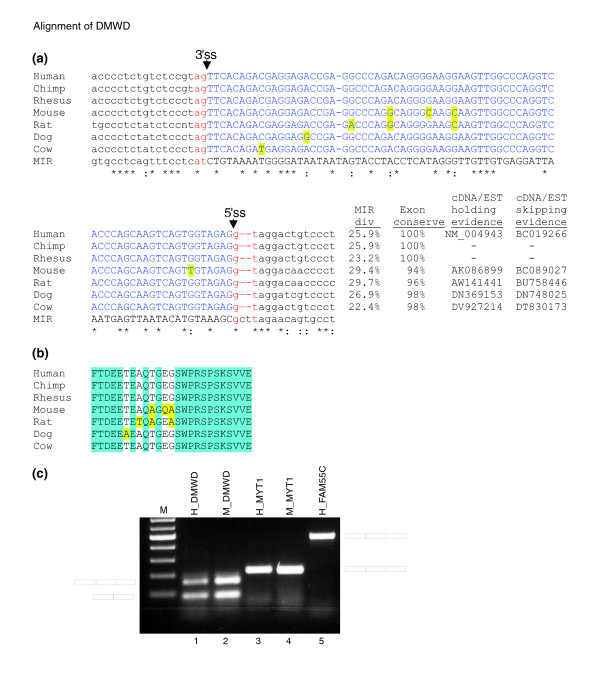
RT-PCR analysis of selected Alu and MIR exons. (a) Multiple alignment of mammalian interspersed repeat (MIR) exon in DMWD gene among mammals. Exon sequences are marked in blue, flanking intronic sequences are marked in black, and the canonical AG and GT dinucleotides at the 3'ss and 5'ss are marked in red. Nucleotide conservation is marked at the lower edge, with asterisks indicate full conservation and colons indicating partial conservation relative to the MIR consensus sequence (lower row). The divergence in percentage from the consensus MIR sequence is indicated under (MIR div); exon conservation in percentage compared with the human exon is indicated under (exon conserve); EST/cDNA accession confirming the exon insertion is indicated under (cDNA/EST holding evidence), and skipping is indicated under (cDNA/EST skipping evidence). Nonconserved nucleotides are marked in yellow. (b) This panel is similar to panel a, except that the conservation is shown for the protein coding sequence. (c) Total RNA was collected from SH-SY5Y human cell line and mouse brain tissue. Reverse transcription polymerase chain reaction (RT-PCR) analysis amplified the endogenous mRNA molecules using primers specific to the flanking exons. The PCR products were separated on an agarose gel, extracted and sequenced. A schema of the mRNA products is shown on the left and right. Columns 1 to 4 show the splicing pattern of orthologous human (H) and mouse (M) exons originating from the MIR element. Columns 1 and 2 show alternative splicing of an ortholog MIR element in both human and mouse, respectively (exon 4 in DMWD gene), and columns 3 and 4 show a constitutive pattern in both species (exon 5 in the MYT1L gene). Column 5 shows constitutive splicing of an Alu element in the human exon 3 of FAM55C gene. All PCR products were confirmed by sequencing. We cannot fully reject the option that an exon that is constitutively spliced under the above conditions is alternatively spliced in other cells or conditions. However, the constitutive selection is also supported by EST/cDNA coverage.